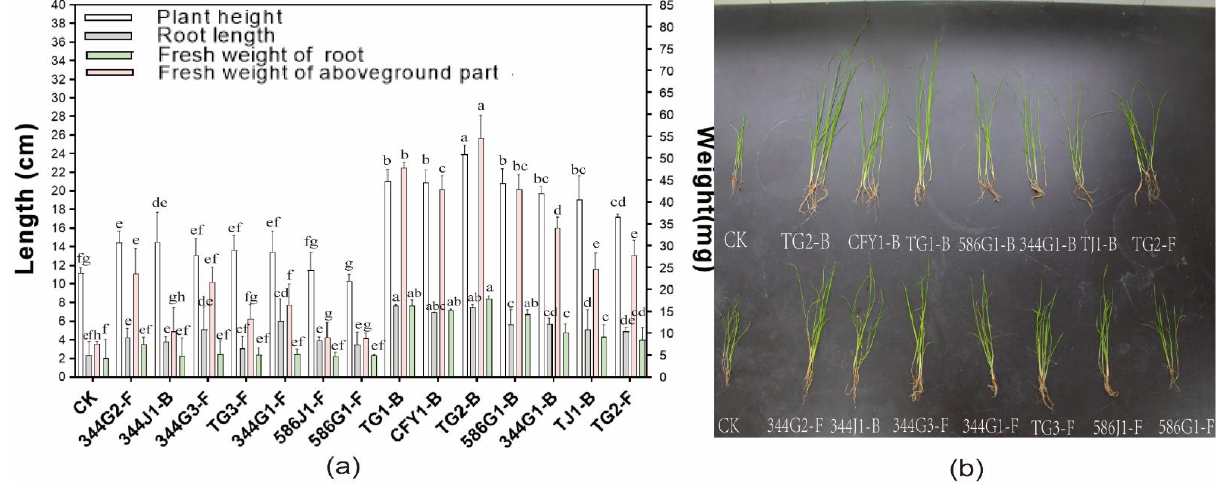
Figure 1. ( a ) Effects of endophytic fungi and bacteria treatment on plant biomass of D. glomerata , different letters on bars mean significantly different at p < 0.05. ( b ) Seedlings showing differences in root and shoot lengths between control and endophytic fungi and bacteria treatments on D. glomerata seedlings after 60 days grown in pots. Table 1. Endophytes isolated from different varieties and different parts of Dactylis glomerata . Sample Name